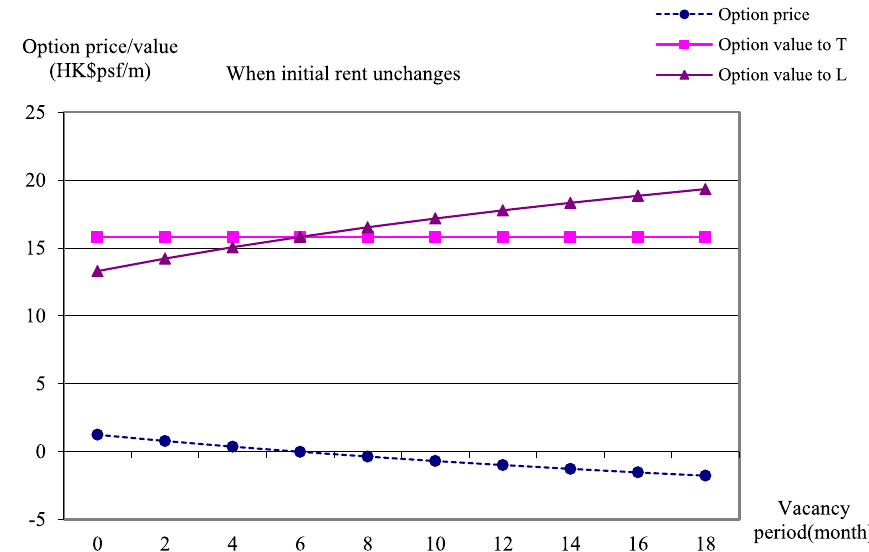
Fig. 7 Effect of vacancy period on option price and option value for both parties